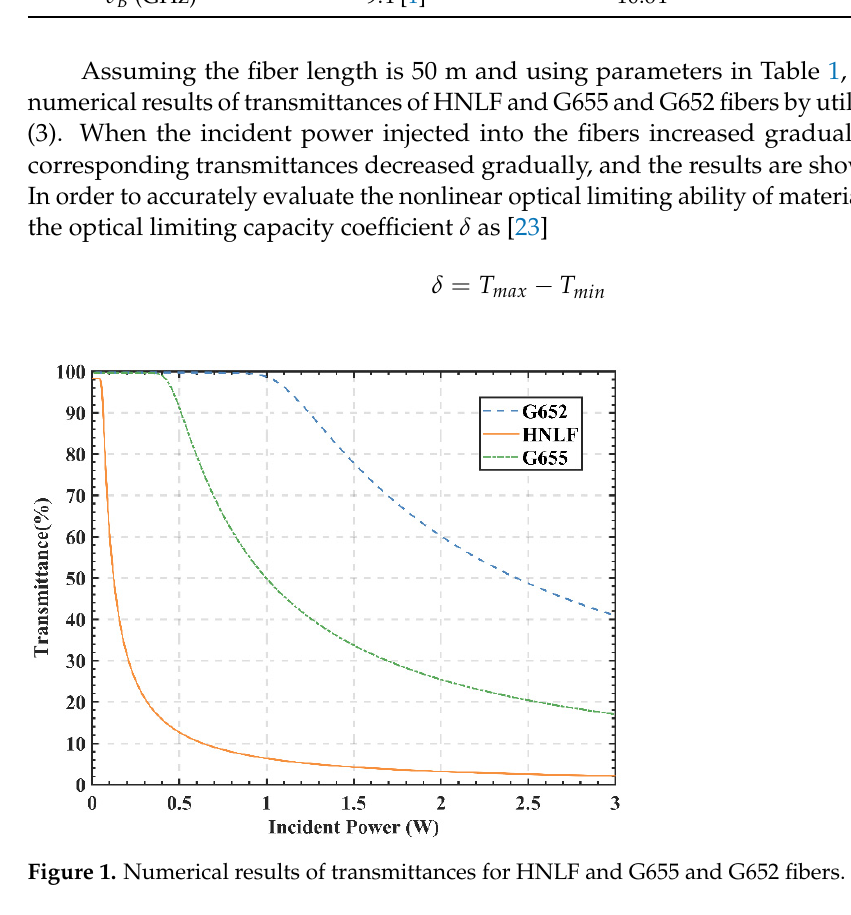
Table 1. Main parameters of three fibers.